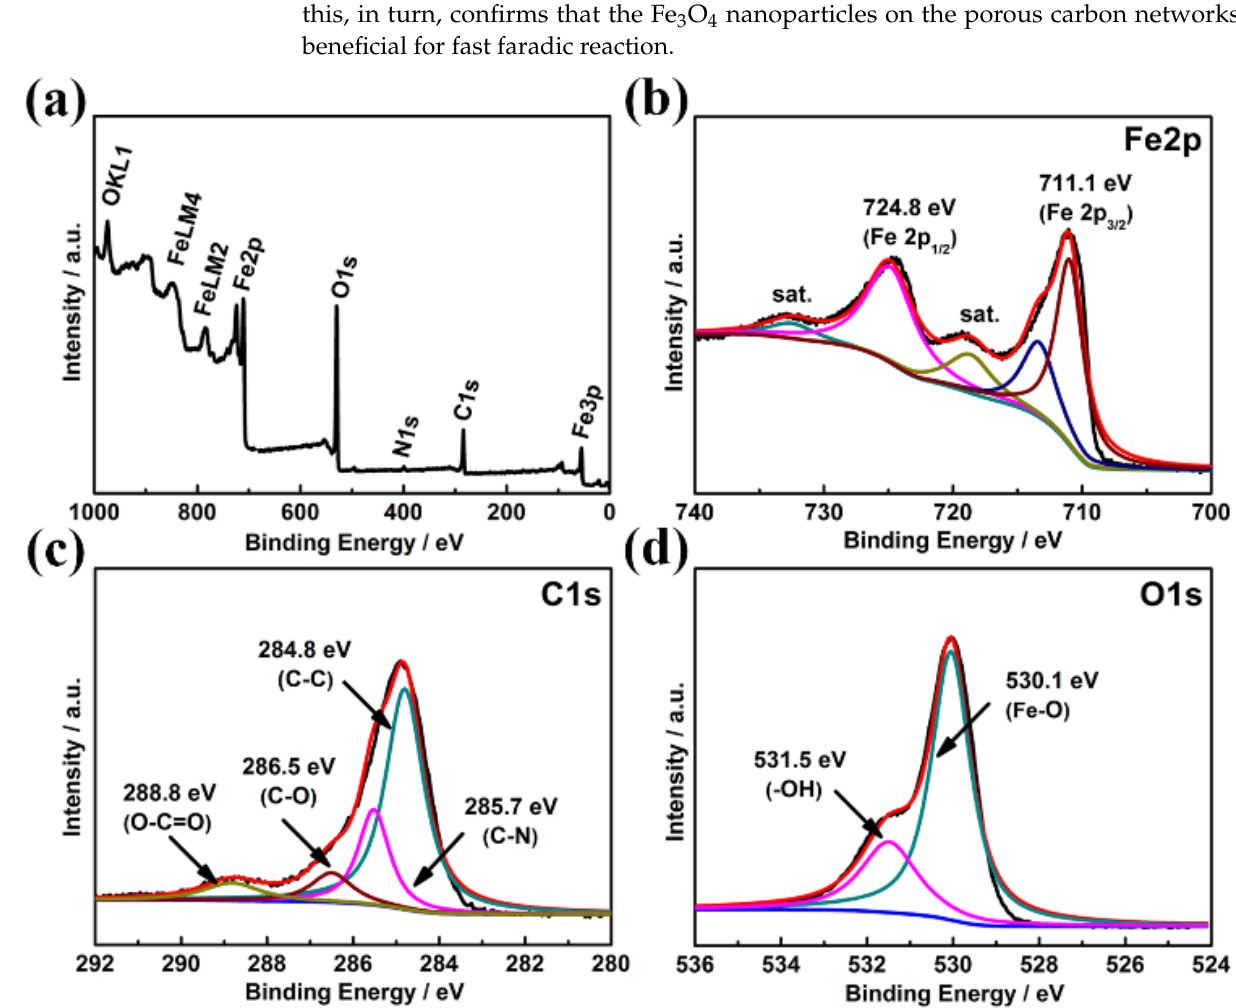
Figure 4. ( a ) wide survey, ( b ) Fe 2p, ( c ) O 1s, and ( d ) C 1s of XPS spectra of Fe 3 O 4 @C.